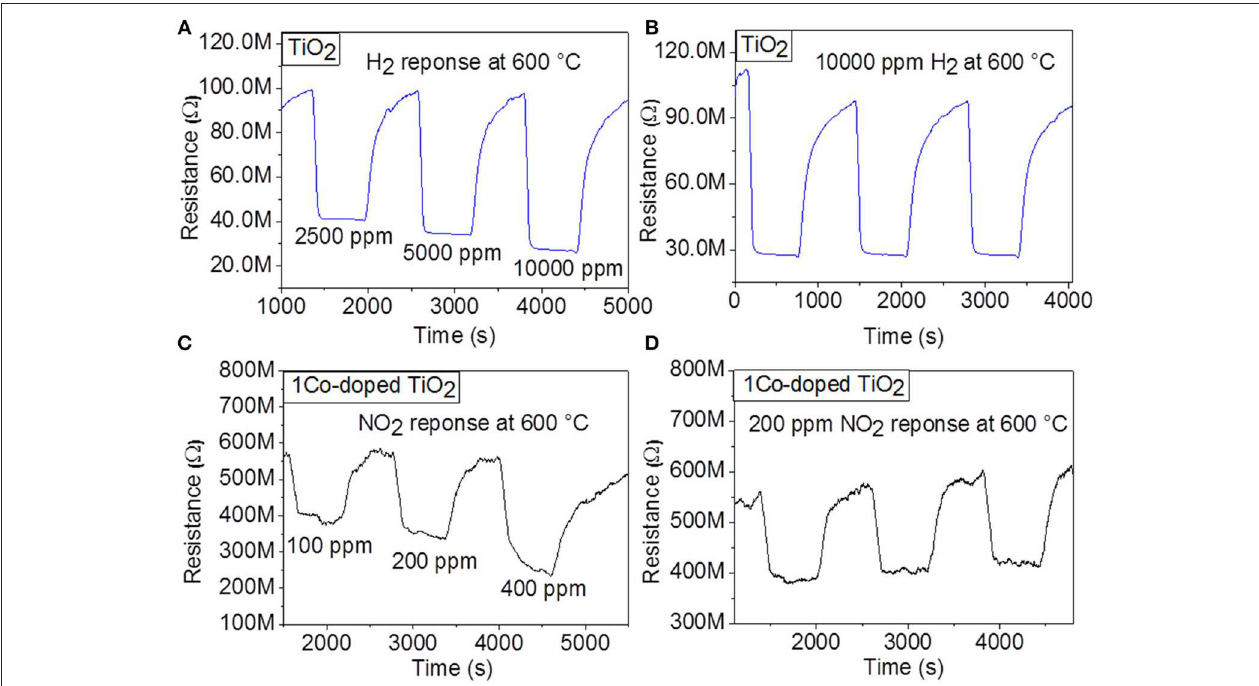
FIGURE 3 | Dynamic response of gas sensors based on TiO 2 and 1Co-doped TiO 2 to various concentrations of (A) H 2 , (C) NO 2, respectively, and to (B) 10,000 ppm H 2 and (D) 100 ppm NO 2 , respectively at 600 ◦